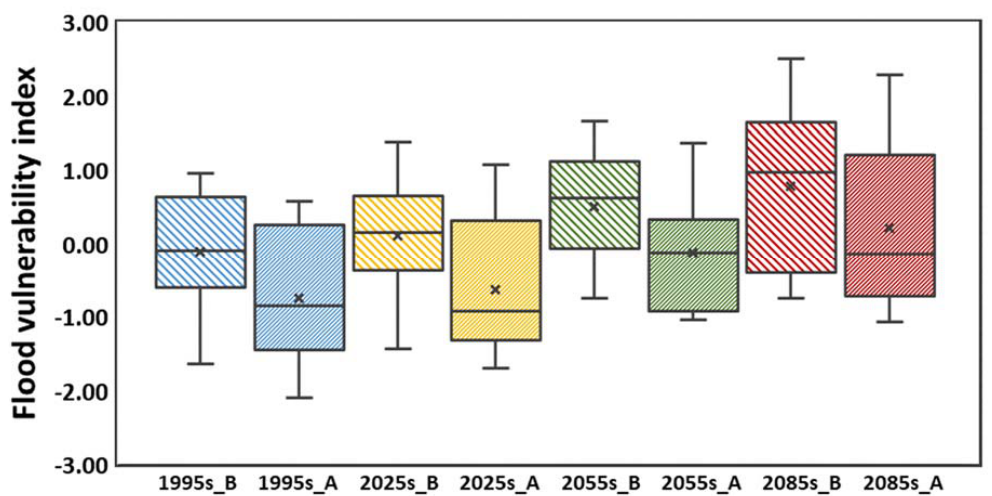
Figure 8. Comparison of flood vulnerability indices before and after dam heightening of for ten reservoirs under climate change. B stands for before dam heightening and A stands for after dam.